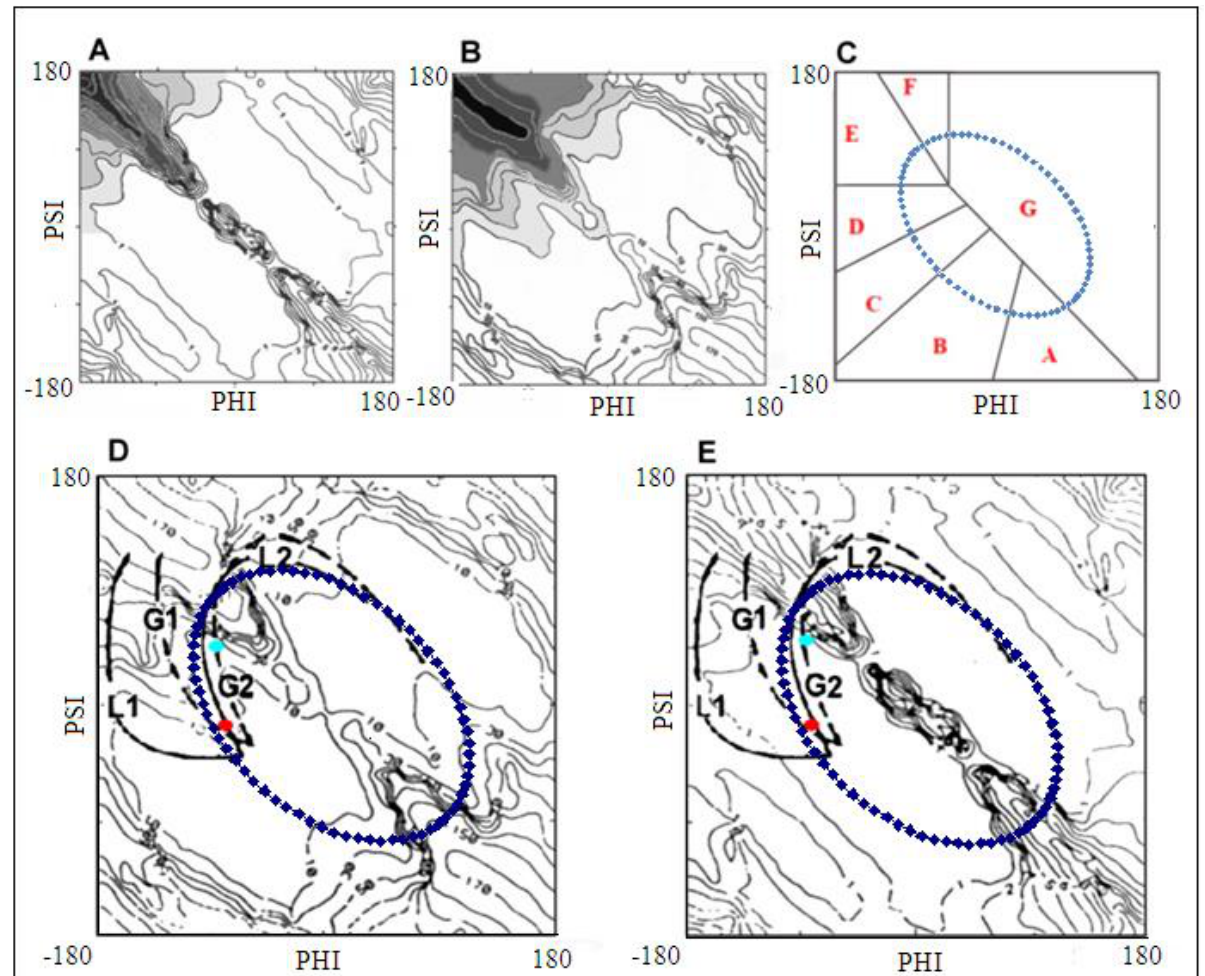
Figure 3. ( A , B )—the distribution of geometrical parameters R, V in early-stage model, ( C )—the zones corresponding to the structural codes and the elliptical path, ( D , E )—the L, G and ellipse paths superimposed on V and R distributions, respectively. Red points—helix 3 10 , turquoise point–helix 2 7